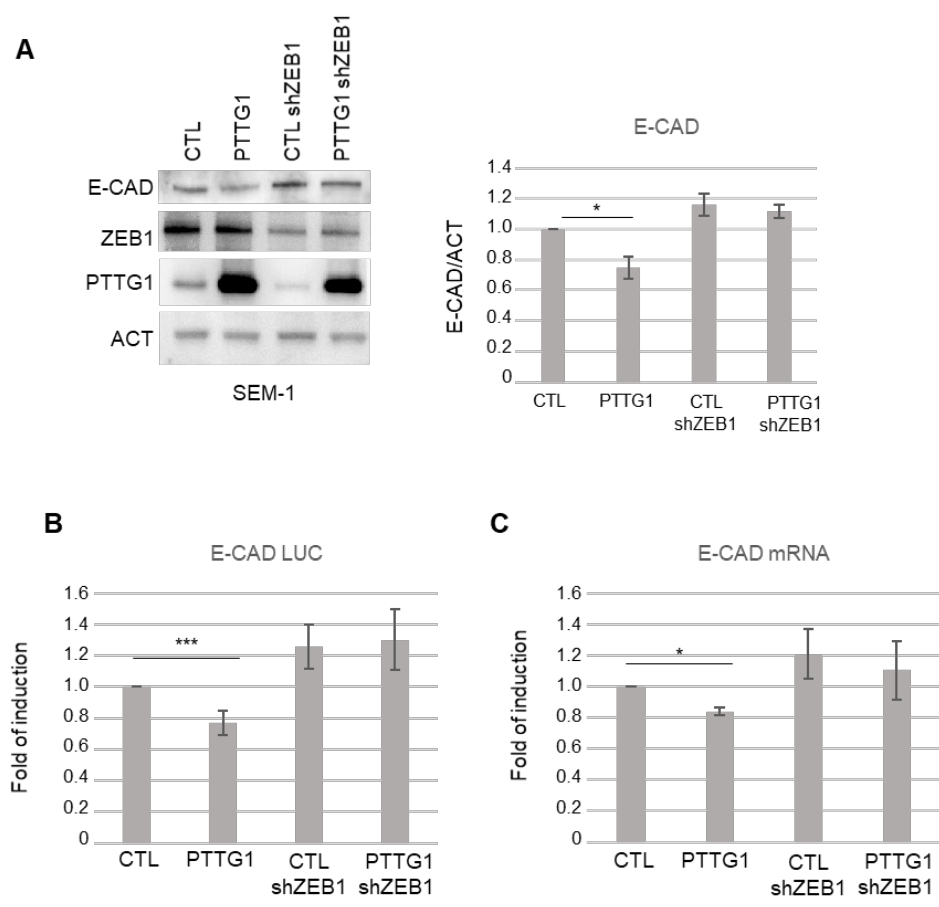
Figure 2. PTTG1 regulation of E-CAD depends on ZEB1 presence. ( A ) Left panel: representative Western blot analysis (Wb) of the indicated proteins in SEM-1 cell line upon PTTG1 overexpression and shRNA of ZEB1 (shZEB1) or control (CTL). Right panel: Histogram shows the ratio of densitometric values of E-CAD to actin (ACT). Mean ± SD of three independent biological replicates is shown (N = 3; * = p < 0.05). ( B ) Histogram shows the fold of induction of luciferase activity in the indicated transfections (as in ( A )), normalized to Renilla signal, set arbitrarily to 1 in control transfection (CTL). Mean ± SD of three independent biological replicates is shown (N = 3; *** = p < 0.001, two-tailed unpaired t -test). ( C ) Histogram shows the fold of induction of E-CAD mRNA relative to actin in the indicated transfections (as in ( A )). Control transfection (CTL) is set arbitrarily to 1. Mean ± SD of three independent biological replicates is shown (N = 3; * = p < 0.05, two-tailed unpaired t -test).